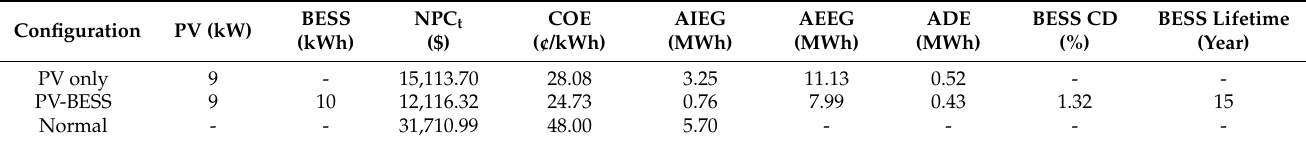
Table 6. Optimal results for both system configurations with Option 1 (Flat–Flat).